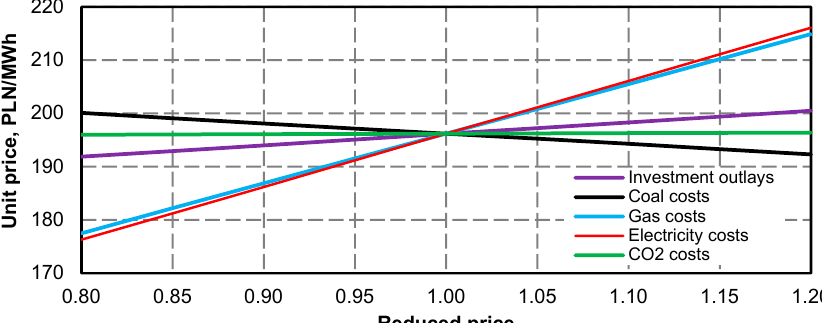
Figure 53. The impact of investment outlays, gas cost, unit cost of power generation before the upgrade,